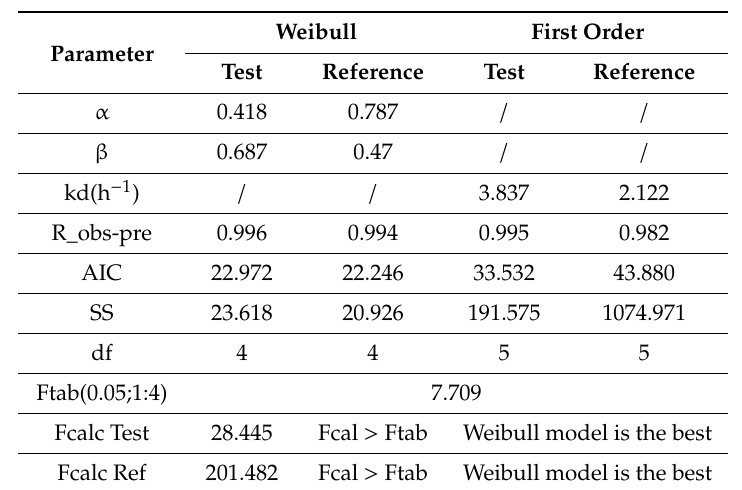
Table 2. Fitted parameters of Weibull function and First order model to the in vitro dissolution